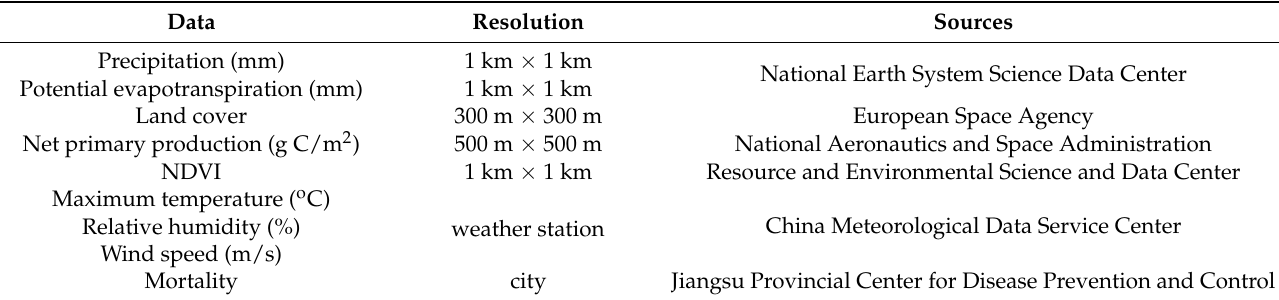
Table 1. Data, resolution and